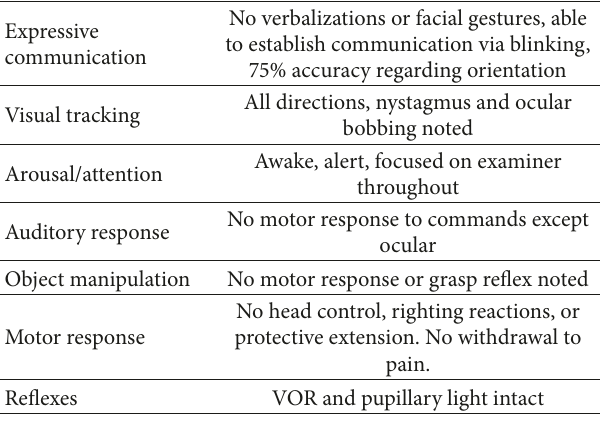
Table 1: Examination findings.